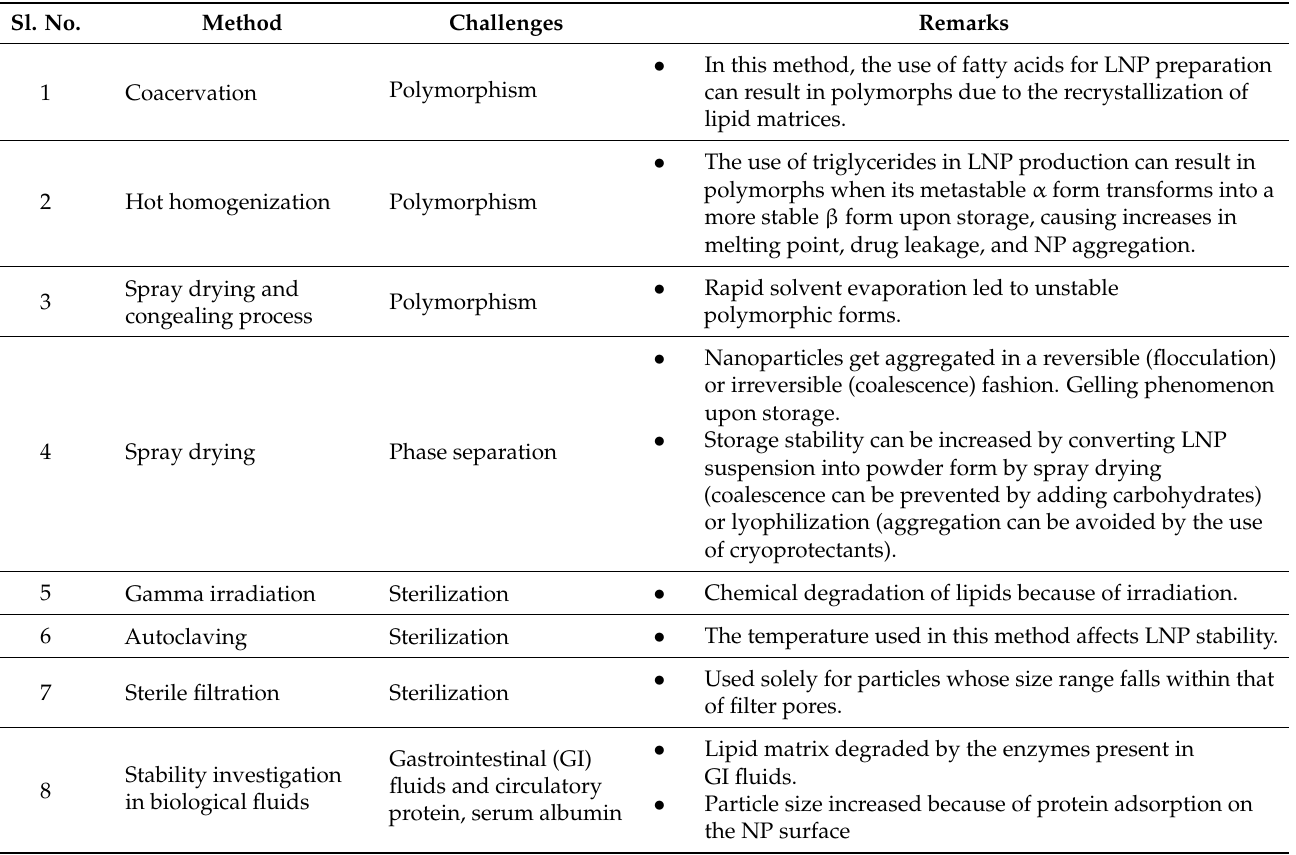
Table 2. Challenges in scale-up methods and stability issues